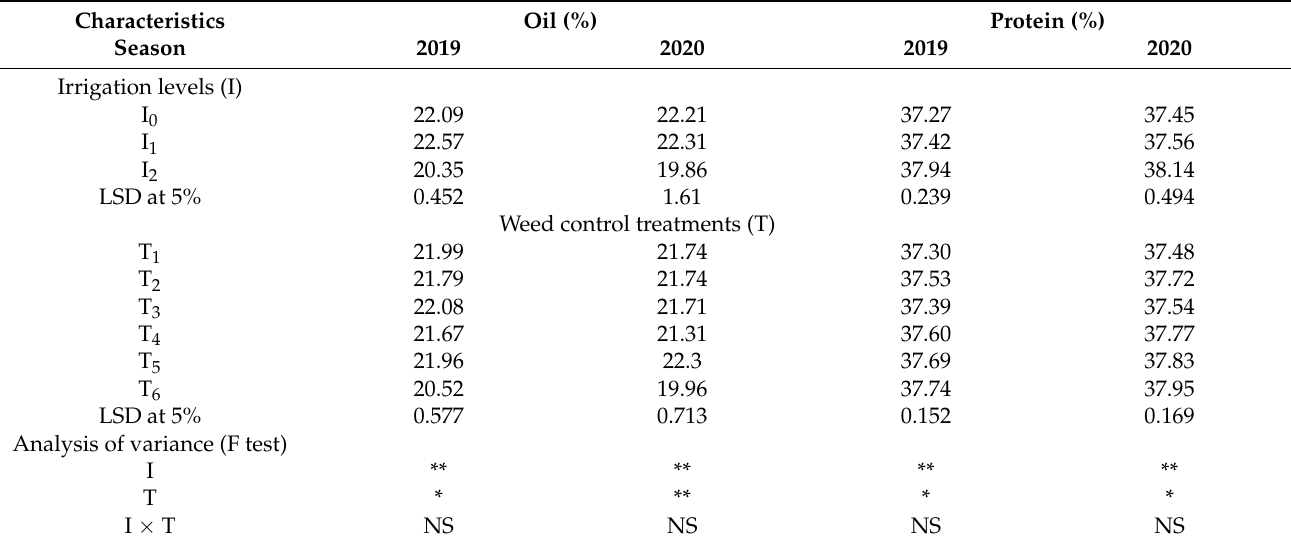
Table 11. Effect of irrigation levels and weed control treatments on chemical composition of soybean seeds in the 2019 and 2020